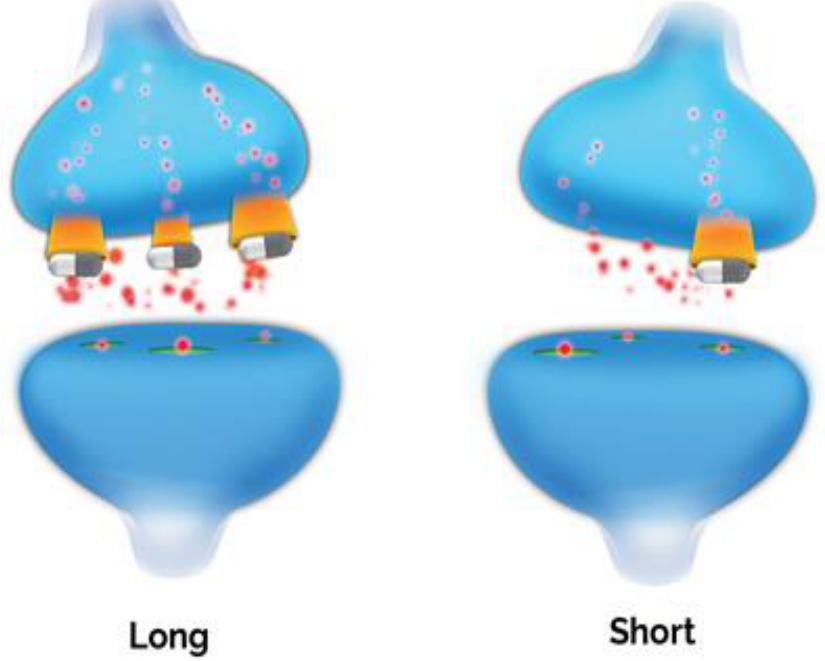
Figure 3. SLA6A4 Alleles. The SLC6A4 promoter variant is among the best studied polymor- phisms in psychiatry. Multiple meta-analyses confirm significantly lower rates of response and remission in S/S and L/S